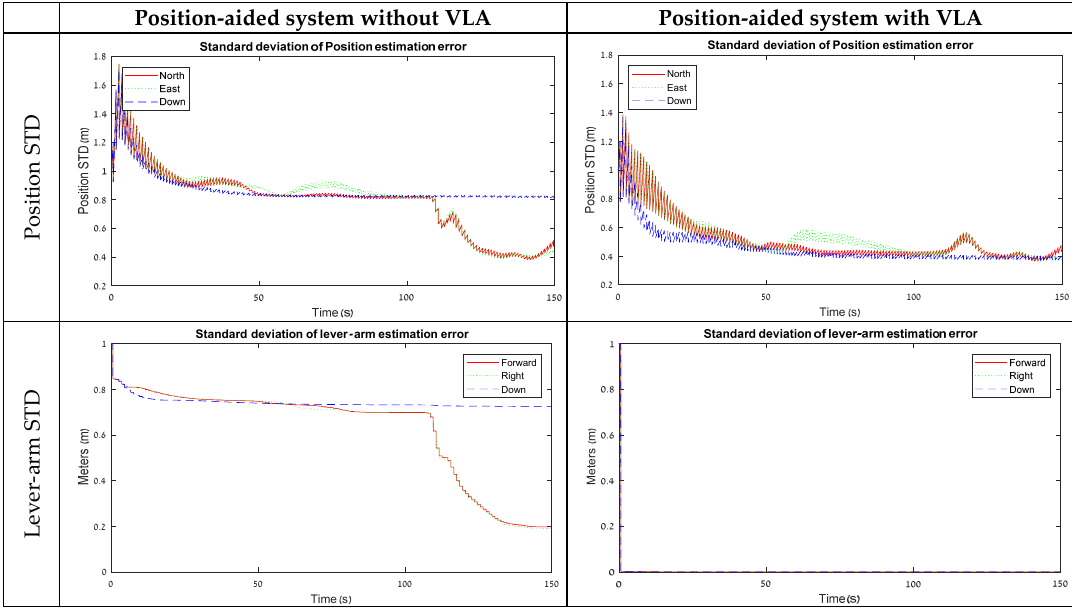
Figure 5. STD results from the field test for position ‐ aided model with and without VLA.